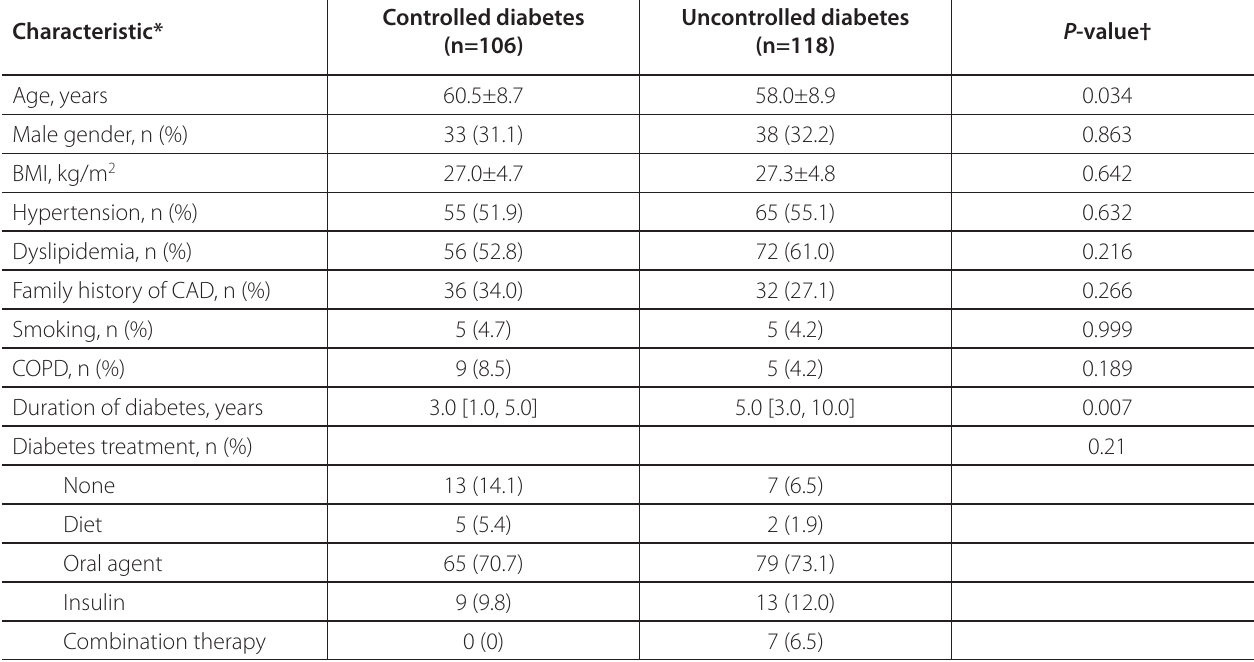
Table 2 . Comparison of the baseline study variables between the study